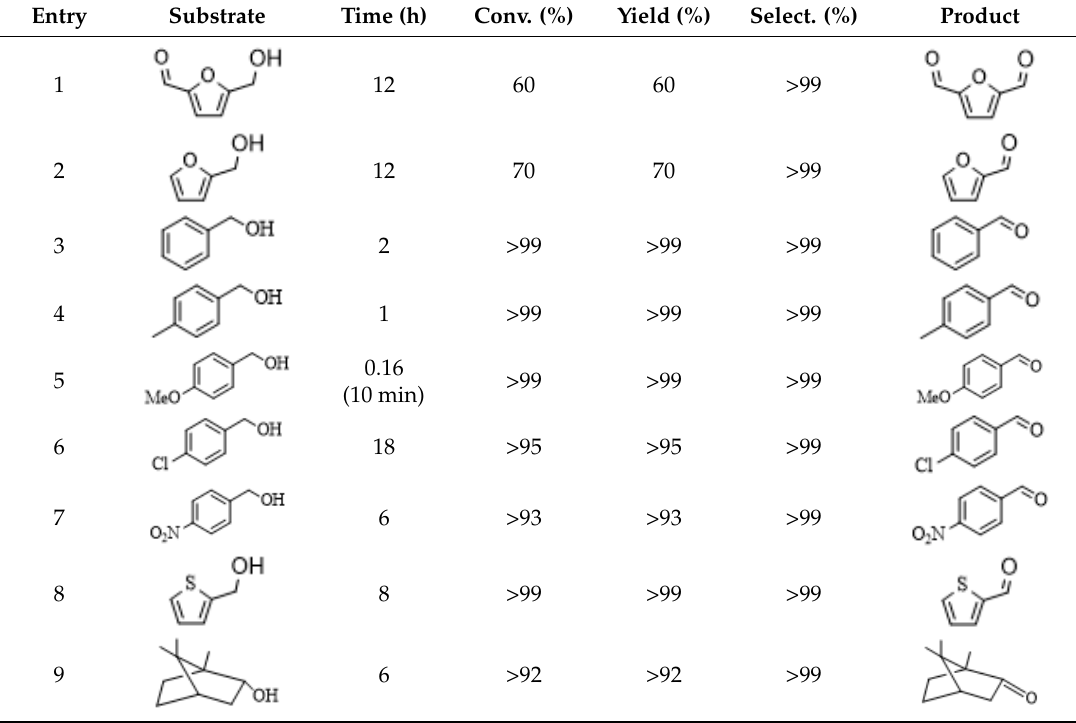
Table 2. RuO 2 /IL–graphene catalyzed selective oxidation of several alcohols with O 2 as an oxidant. Entry Substrate Time (h) Conv. (%) Yield (%) Select. (%) Product